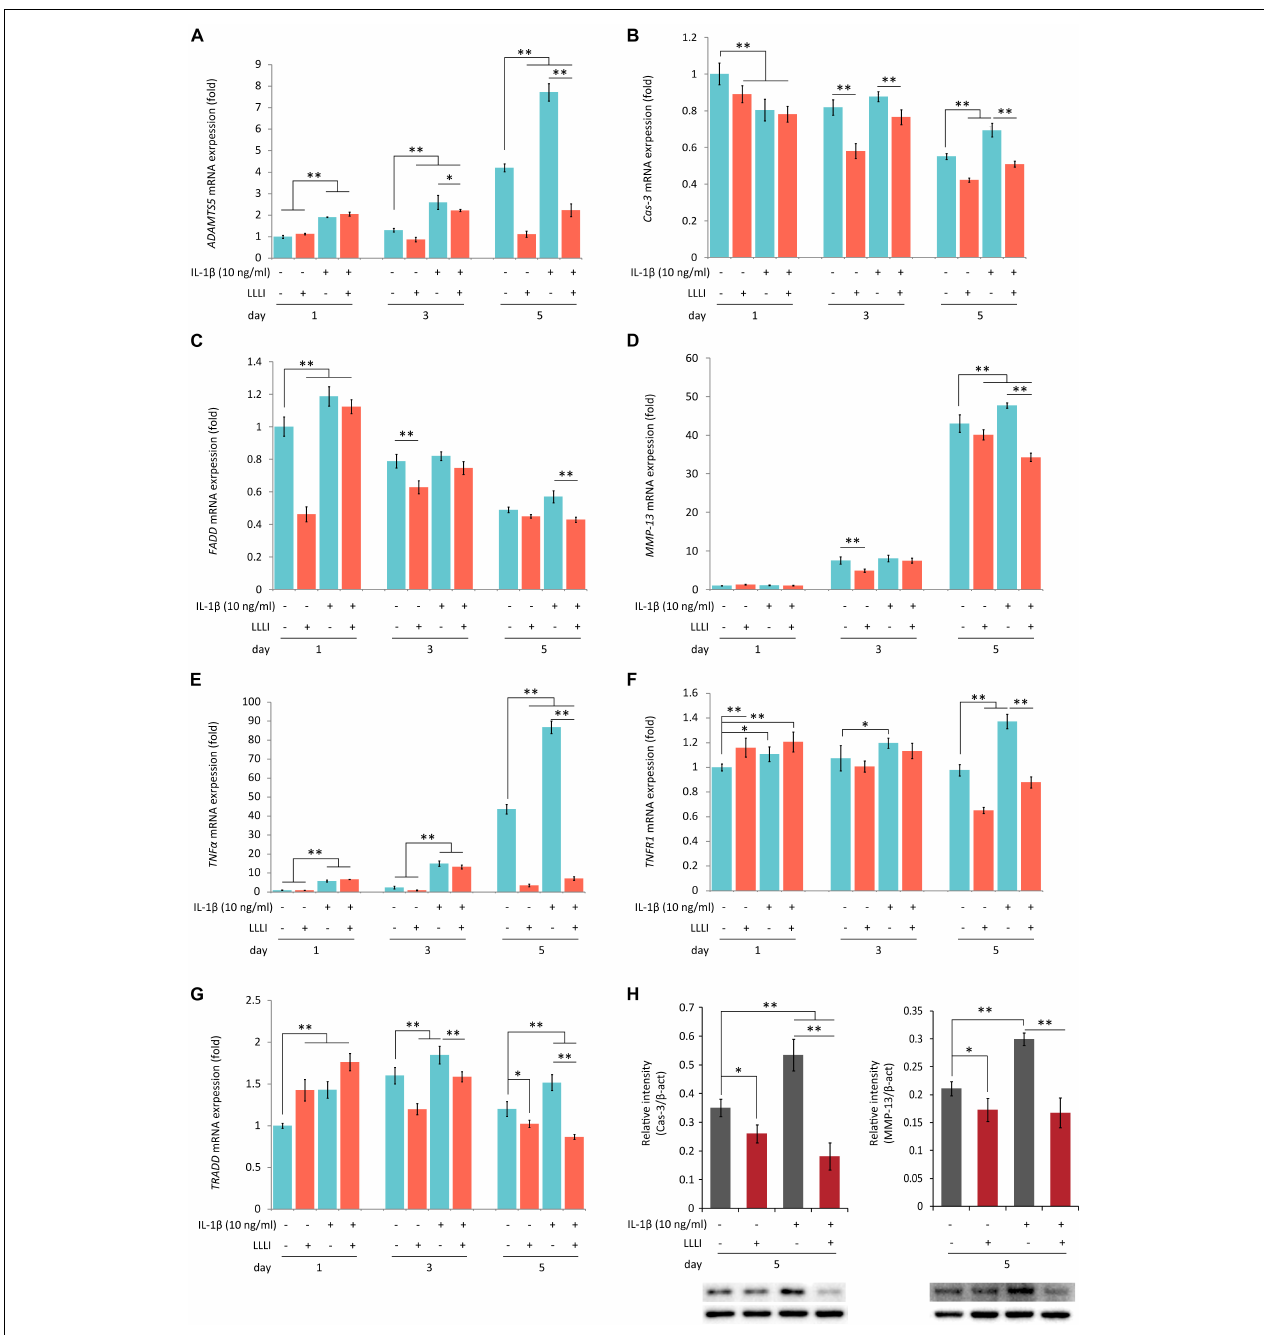
FIGURE 5 | Protein Western blots and qRT-PCR analysis of the expression of genes associated with cell death and matrix destruction in rabbit chondrocytes. The cells were treated with pro-inflammatory cytokine IL-1 β , and LLLI of 5.74 J/cm 2 daily in culture for 1, 3, and 5 days, respectively, or simultaneously treated with IL-1 β , followed by further culture for 24 h before harvested for isolating total RNA ( n = 3). The comprehensive review of LLLI-regulated expression of the genes revealed 3 major patterns: (1) the “destructive” genes expressed at low basal level under the influence of treatment with LLLI of 5.74 J/cm 2 daily in culture for 1 day, such as ADAMTS5 (A) , MMP-13 (B) , and TNF- α (E) ; (2) differentially expressed cell death mediator genes at a high basal level, such as Cas-3 (B) , FADD (C) , TNFR1 (F) , and TRADD (G) ; (3) treated by LLLI of 5.74 J/cm 2 daily in culture for 3 days, the IL-1 β -induced expression of ADAMTS5 (A) and Cas-3 (B) were downregulated. The LLLI of 5.74 J/cm 2 daily in culture for 5 days decreased the expression of genes involved except FADD (C) ; all the genes were highly increased by IL-1 β , then counteracted by the LLLI of 5.74 J/cm 2 daily in culture for 5 days. The GAPDH was used as an internal reference. The altered protein expression associated with LLLI-modulated gene expression were carried out by Western blot analysis, which showed significantly decreased Cas-3 ( H , left) and MMP-13 ( H , right) by LLLI of 5.74 J/cm 2 daily in culture for 5 days. The charts were plotted using data from triplicated samples, each of which was experimented in triplicates. Daily LLLI treatment = 5.74 J/cm 2 of LLLI for 8 min; Error bar = SD; ∗ P < 0.05 and ∗∗ P < 0.01.